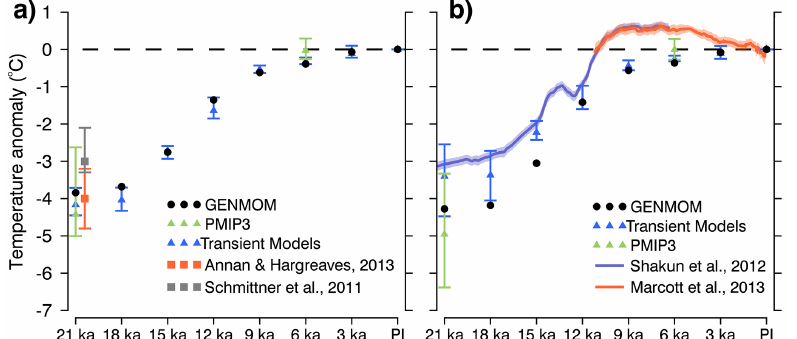
Figure 5. Simulated and reconstructed changes in temperature from 21ka to present. (a) Global mean surface air temperature from GEN- MOM compared to the PMIP3 ensemble average and three transient models (CCSM – Liu et al., 2009; LOVECLIM – Timm and Timmer- mann, 2007; and FAMOUS – Smith and Gregory, 2012). The transient model values are averages over a ± 50-year window centered on the eight time slices. The symbols for the PMIP and transient models are the average of the ensembles and the bars represent the range of the ensembles. Data-model estimates of mean and range of LGM cooling by Annan and Hargreaves (2013) and Schmittner et al. (2011b) are offset from 21ka for legibility. (b) Temperature change at the proxy sites used in the reconstructions by Shakun et al. (2012) and Marcott et al. (2013). The models were bilinearly interpolated and aggregated to the 5 ◦ × 5 ◦ boxes around the proxy sites as in Marcott et al. (2013). The 1 σ uncertainty in the reconstructions is indicated by the shaded band. Marcott et al. (2013) is adjusted to a preindustrial ( ∼ 1850) base value rather than the original 1961–1990. Data younger than preindustrial are removed. The Shakun et al. (2012) and Marcott et al. (2013) time series are joined at their 11.5–6.5ka